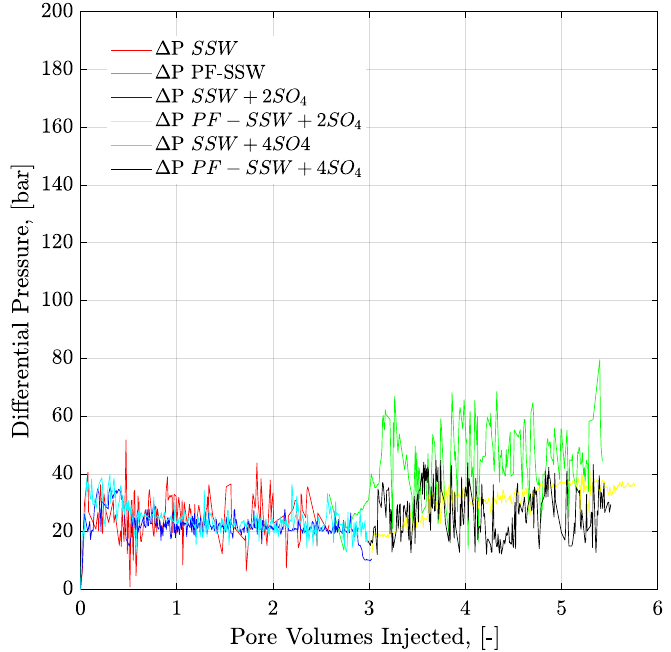
Figure 19. Pressure drop versus PV injected for 6-weeks aged core plugs. Brine injection (≈41–52 g/l TDS) is performed in secondary mode while polymer flood (half to the oil viscosity) in the tertiary mode. ΔP SSW represents the pressure drop for synthetic seawater. ΔP PF-SSW represents the pressure drop for polymer injection having viscosity half to the oil prepared in synthetic seawater. Similarly ΔP SSW + 2SO 4 and ΔP SSW + 4SO 4 denotes pressure drop for polymers in synthetic seawater with doubled amount of sulfate and synthetic seawater with quadruple amount of sulfate, respectively.